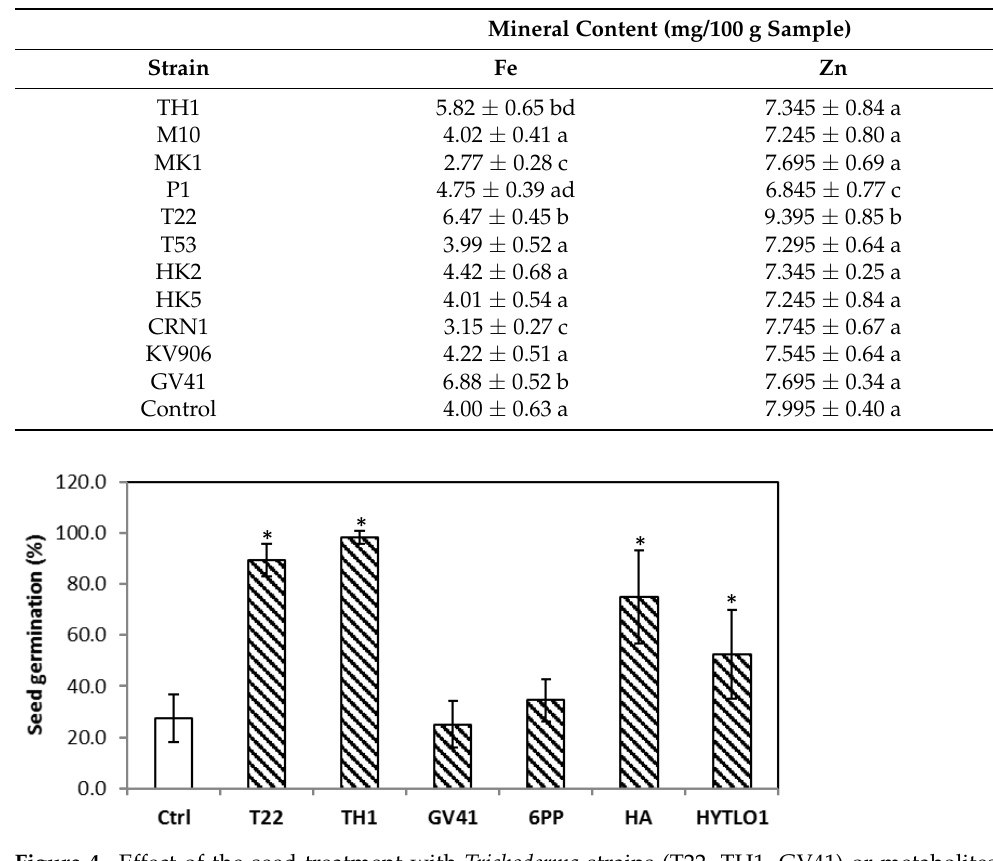
Figure 3. Effects of treatments based on different Trichoderma strains (TH1, M10, MK1, P1, T22, T53, HK2, HK5, CRN1, KV906, GV41) on the yield of lentil plants (expressed as fresh weight of seed pods per treatment). Data represent the mean value of three biological replicates ± standard error. The treatments consisted of two applications of spore suspensions, first to the seeds and then, 4 weeks later, to the soil. Water treatments served as controls (CTRL). After 7 d, another soil watering was carried out using the 1X FeZn solution. Asterisks indicate significant differences (* p < 0.05; ** p < 0.01) compared with the control. Statistical analysis was carried out using the one-way ANOVA. Table 4. Effects of Trichoderma strains (TH1, M10, MK1, P1, T22, T53, HK2, CRN1, KV906, GV41) on the lentil mineral content. Water treatments served as controls (CTRL). Data represent the mean value of three biological replicates ± standard deviation (SD). Different letters in a column indicate statistically significant differences for p < 0.05.